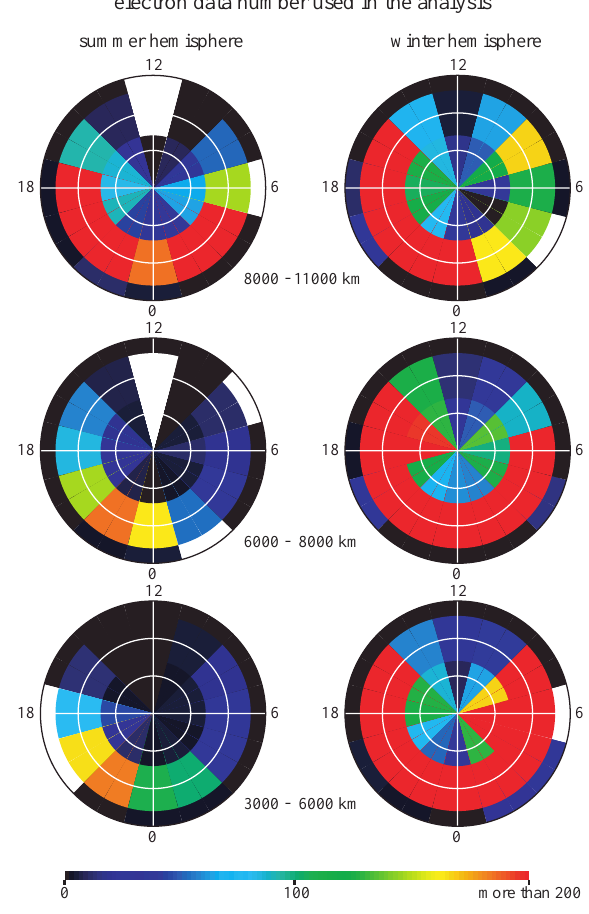
Fig. 1. The data number of accelerated electron events counted with units of the 8-s data point. The data are divided in MLT, MLAT, alti- tudes, and seasons. Each panel indicates the invariant latitude-local time map for each altitude range and season. The top panels indicate the high altitude range data above 8000km to 10000km. The mid- dle panels are for middle altitude range, 6000km to 8000km. The bottom panels are for low altitude range below 6000km. The left and right side panels are data obtained in the summer and the winter hemisphere, respectively. The color bar is displayed in linear. The red color indicates the number of data more than